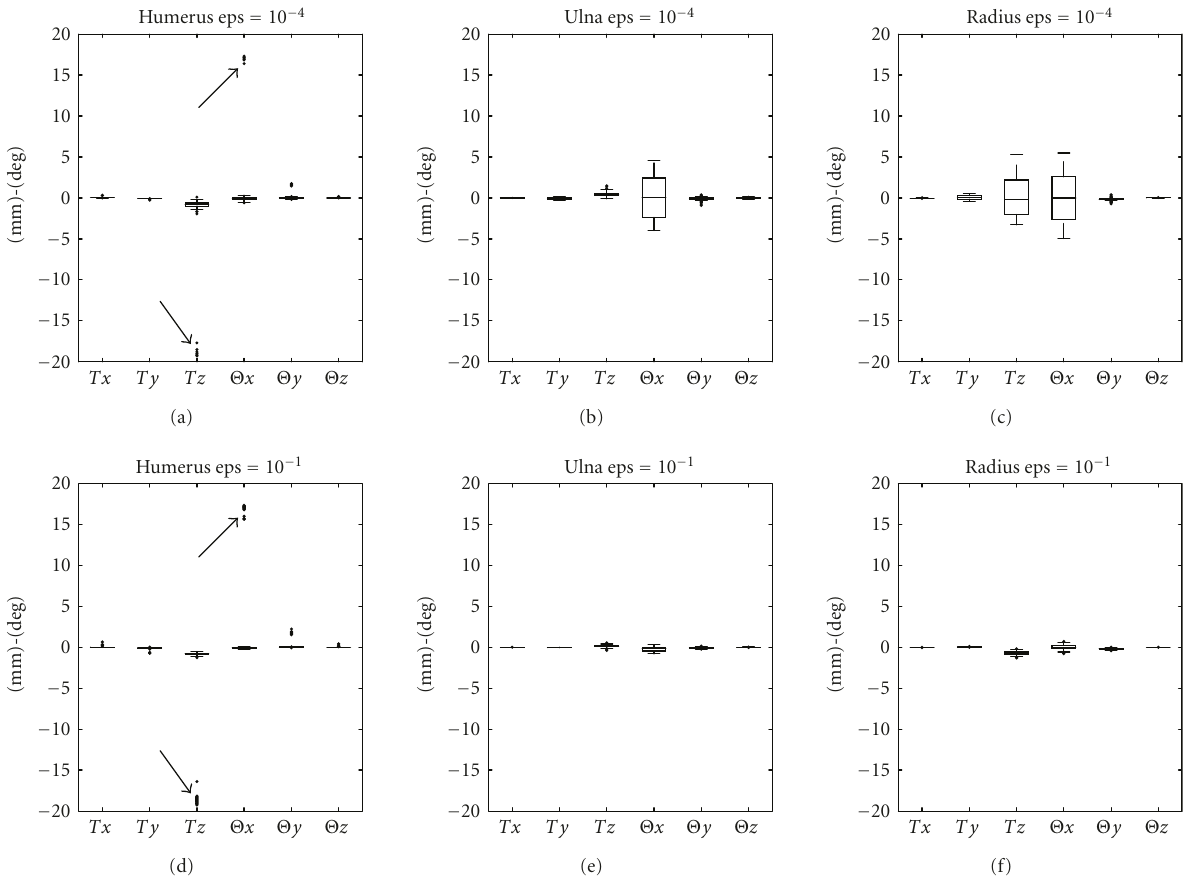
Figure 5: Box and whisker plots of the feat alignment with DMR = 0.5, (panels a, b, c) eps = 10 − 4 mm/deg, or eps = 10 − 1 mm/deg (panels d, e,